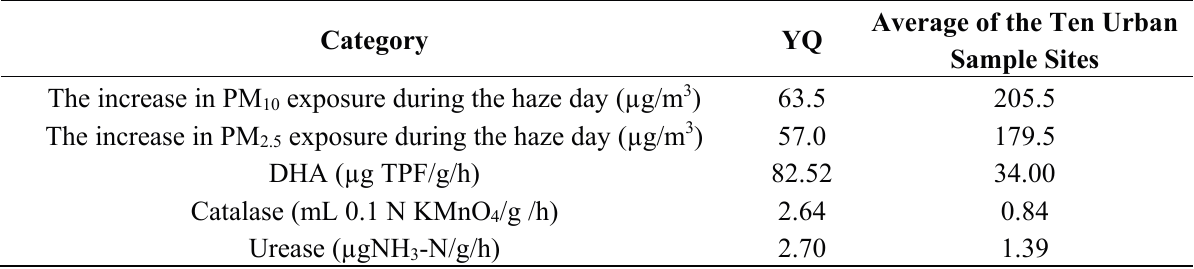
Table 2. The comparison of pollutant exposure and soil enzyme activities between the rural sample in Yanqing and the average of the ten urban samples in urban areas of